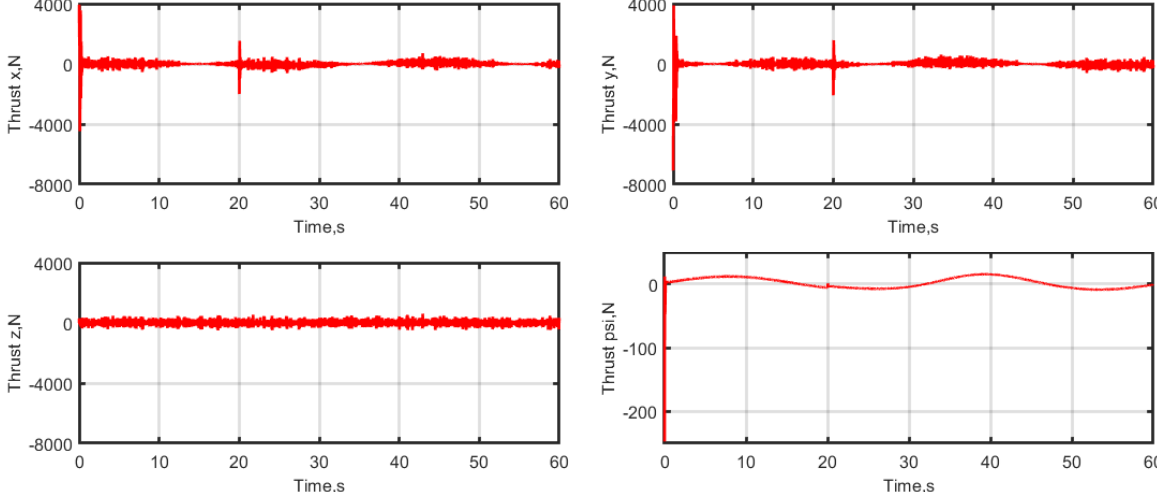
Figure 6. Output thrust on four controllable degrees of freedom.